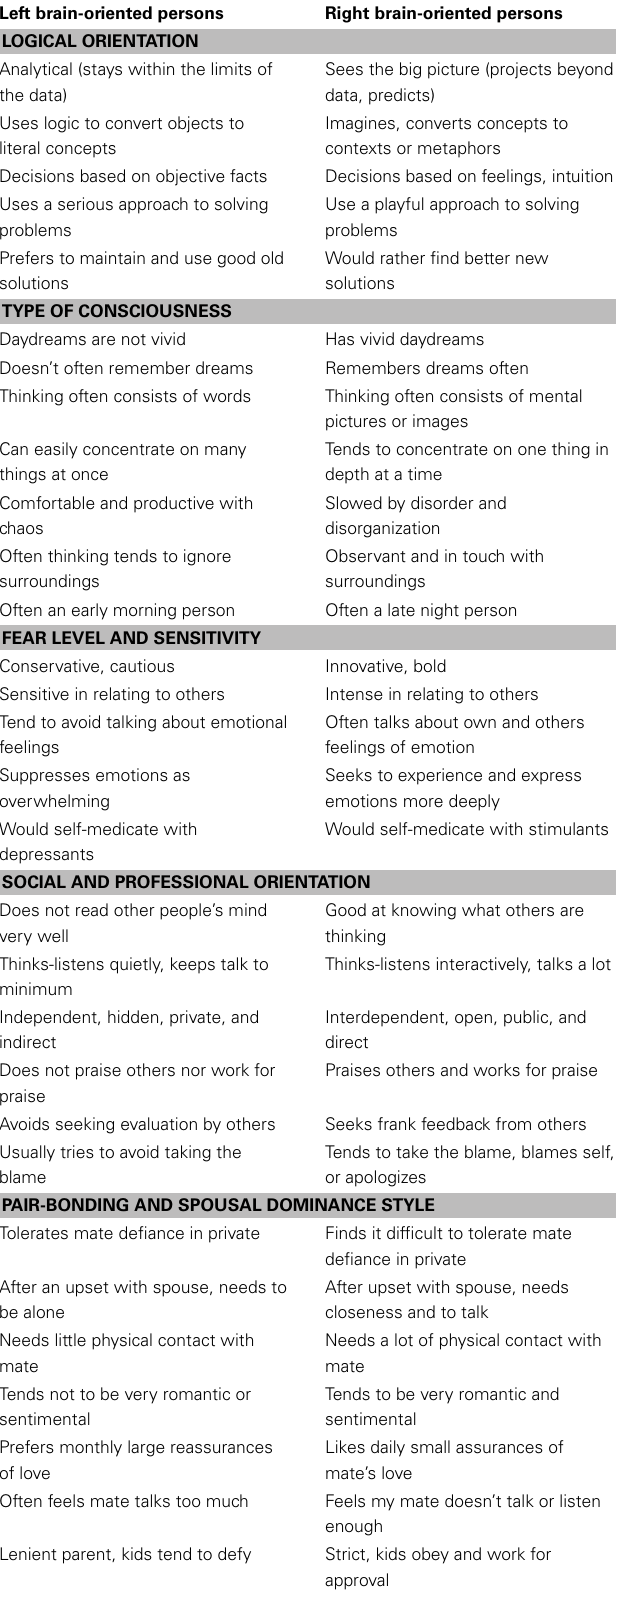
Table 3 | Thirty binary behavioral correlates of